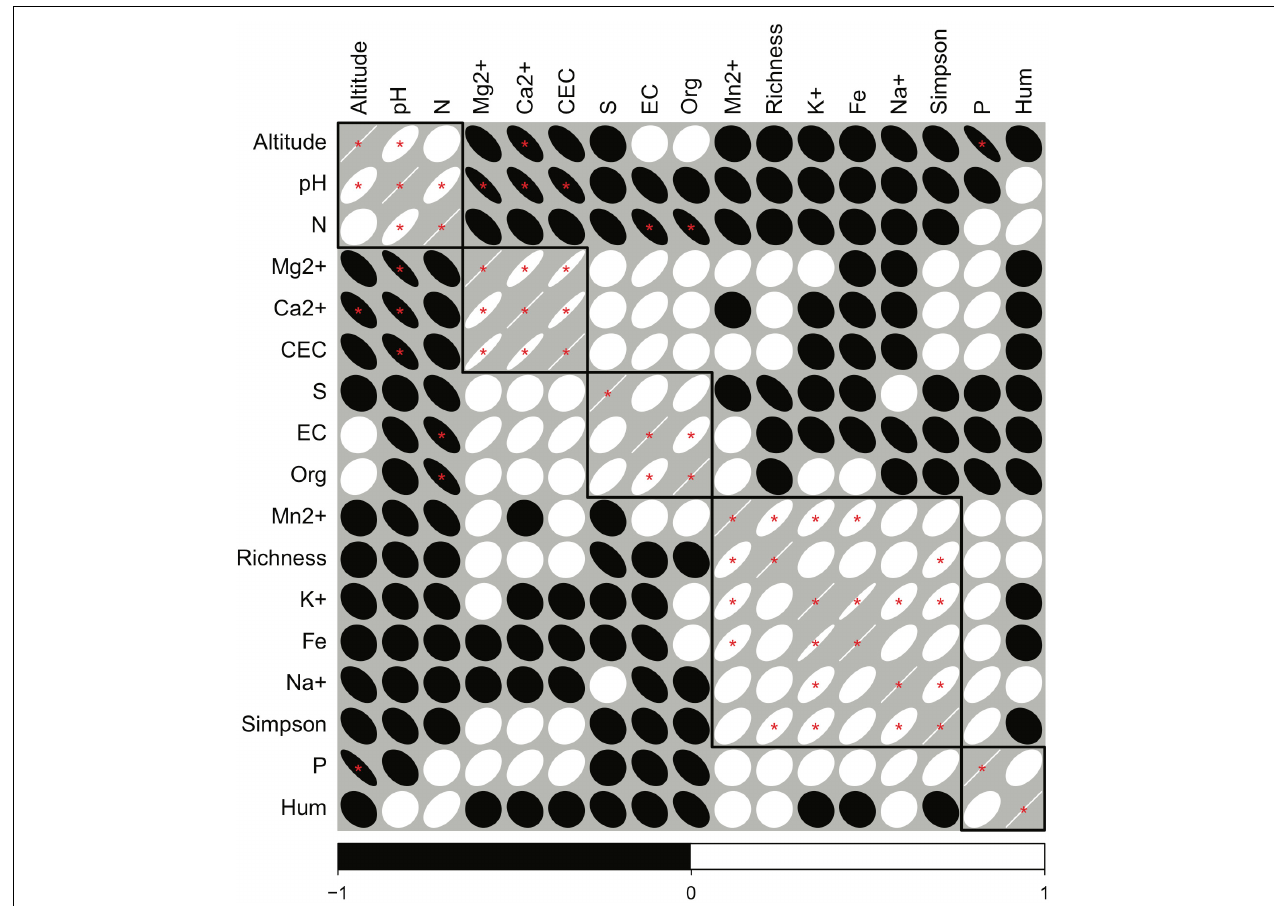
FIGURE 4 | Correlogram of the environmental constraints. Black squares show the selected groups after a clustering analysis on the Pearson correlation distances. Red asterisks show significant correlations at P < 0.05. White ovals are positive correlations and black ovals negative correlations. The strength of the correlation is represented by oval narrowness. Richness and the Simpson diversity index are also included as references for variable